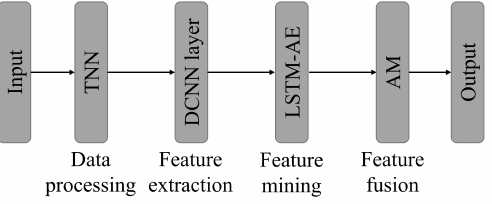
Figure 2. Architecture of the proposed